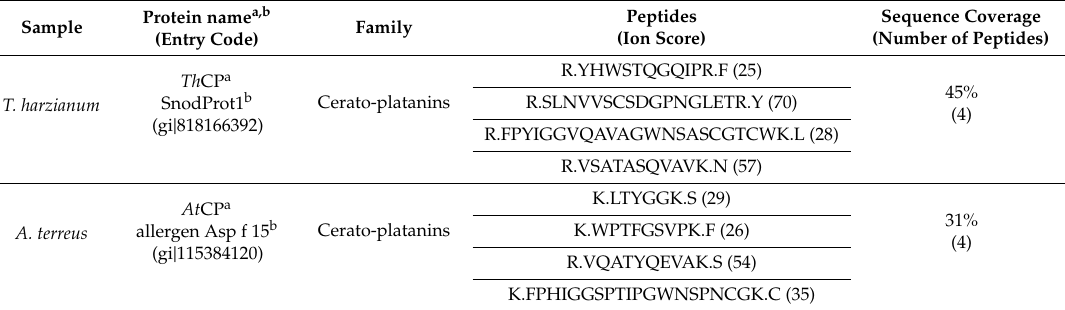
Table 1. Proteins were identified by searching NCBI database with MSMS Ion search Mascot software (Matrix Science) with Fungi as the taxonomy restriction, with carboxyamidomethylation of Cys as fixed modifications, and oxidation on Met, pyro-Glu formation at Gln at the N-terminus of peptides as variable